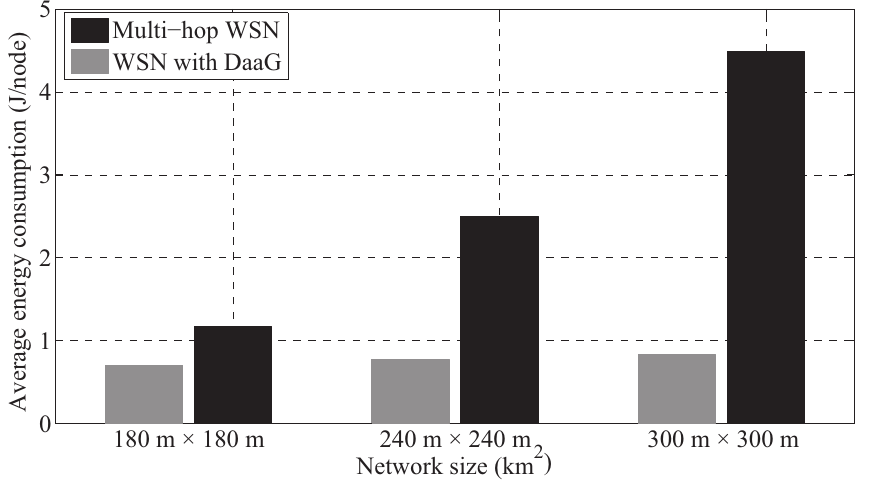
Figure 6. Average energy consumption with various network sizes.